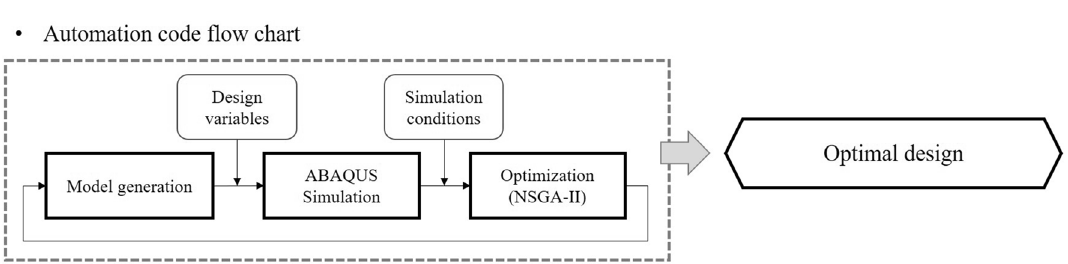
Figure 3. ( a ) Schematic of toe off simulation condition with prosthetic foot; ( b ) Simulation procedure during the HO–TO cycle and target stiffness curve compared with actual human walking.